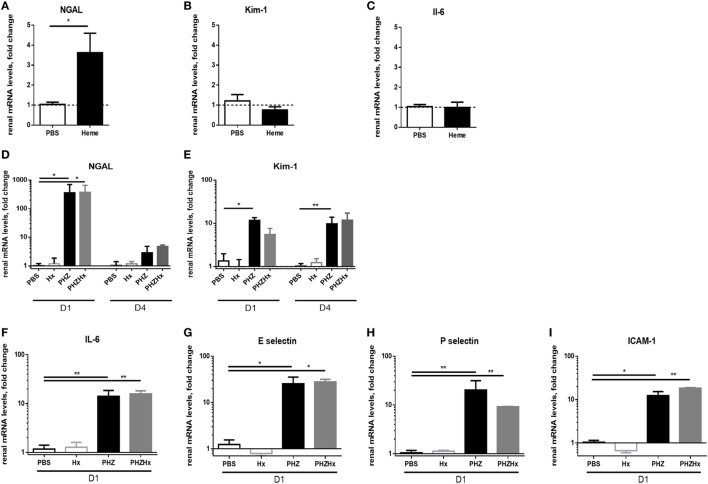
The renal injury which is largely heme-independent. mRNA levels of NGAL (A), Kim-1 (B), and IL-6 (C) in renal tissue after injection of heme at day 2. Influence of hemopexin (Hx) on mRNA level in the phenylhydrazine (PHZ) model, (D) NGAL, (E) Kim-1, (F) IL-6, (G) E-selectin, (H) P-selectin, and (I) ICAM-1 at day 1 or day 4, as mentioned under the panels. * p < 0.05, ** p < 0.005, Mann–Whitney test for (A–C), and Kruskal–Wallis with Dunn’s test for multiple pairwise comparisons for (D–I). Panels (A–C) compare genes expression after two injections of heme at day 0 and day 1. Panels (D,E) compare the genes expression at days 1 and 4 (D1 and D4) after injection of PHZ ± Hx. The remaining panels show results for D1 after injection of PHZ ± Hx.